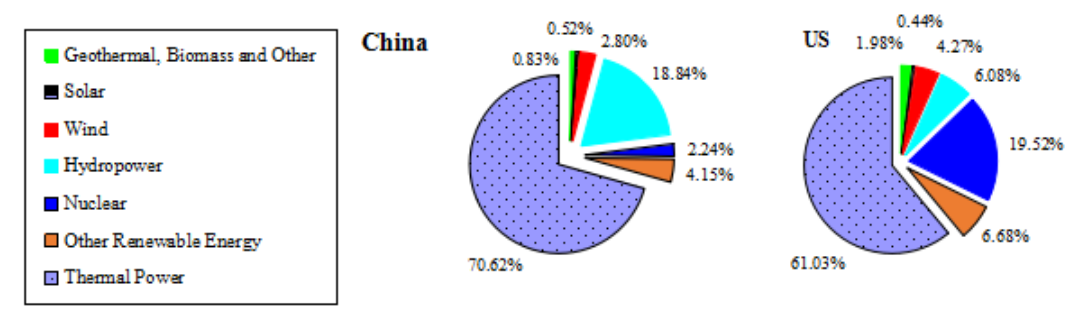
Figure 6. Comparison of ( a ) wind power and ( b ) solar power between China and the US.